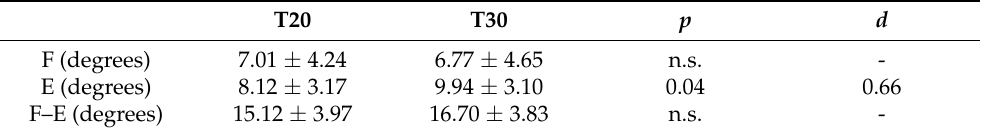
Figure 1. Movement of head extension at the two different test sessions. Table 2. Values of the cervical spine biomechanical parameters during the two test sessions.